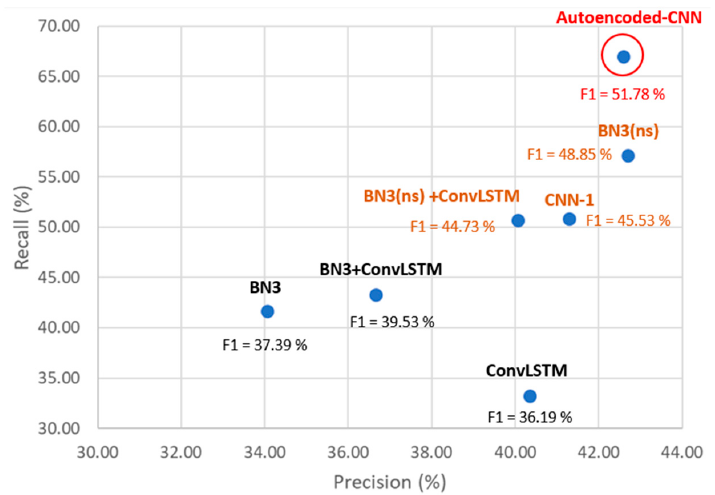
Figure 14. Precision versus recall scatter plot for LBP impact on neural network architecture comparison.